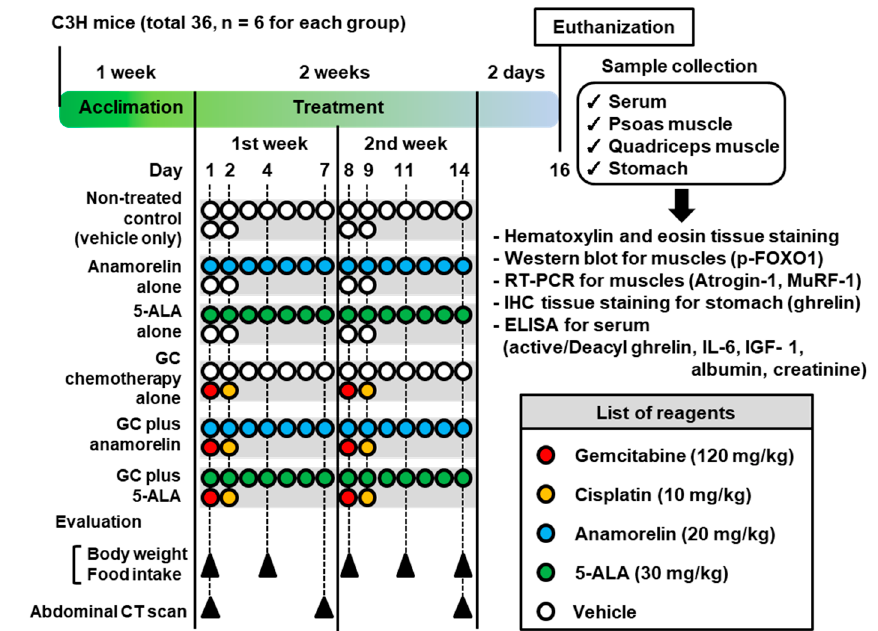
Figure 1. Experimental design of this study. Abbreviations: 5-ALA—5-aminolevulinic acid; GC— gemcitabine and cisplatin combination chemotherapy; CT—computed tomography; p-FOXO1—